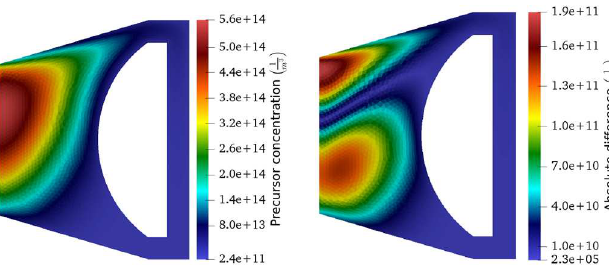
Fig. 4. The reduced order solution for the precursor concentra- tion in group eight together with its absolute deviation from the full order solution.